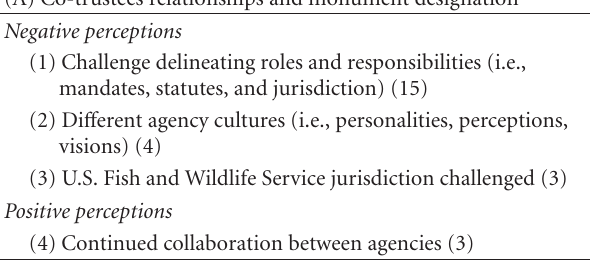
Table 3: Inter-agency processes: interviewee responses by concep- tual category (a)–(d). Numbers in parentheses indicate number of responses from a total pool of 23